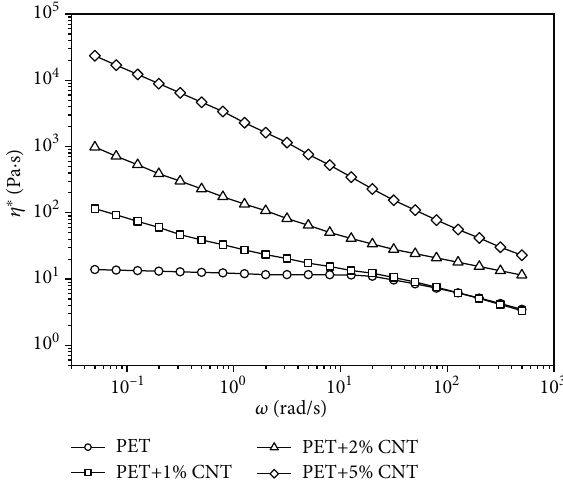
Figure 5: PET/CNT nanocomposite complex viscosity η ∗ ð ω Þ